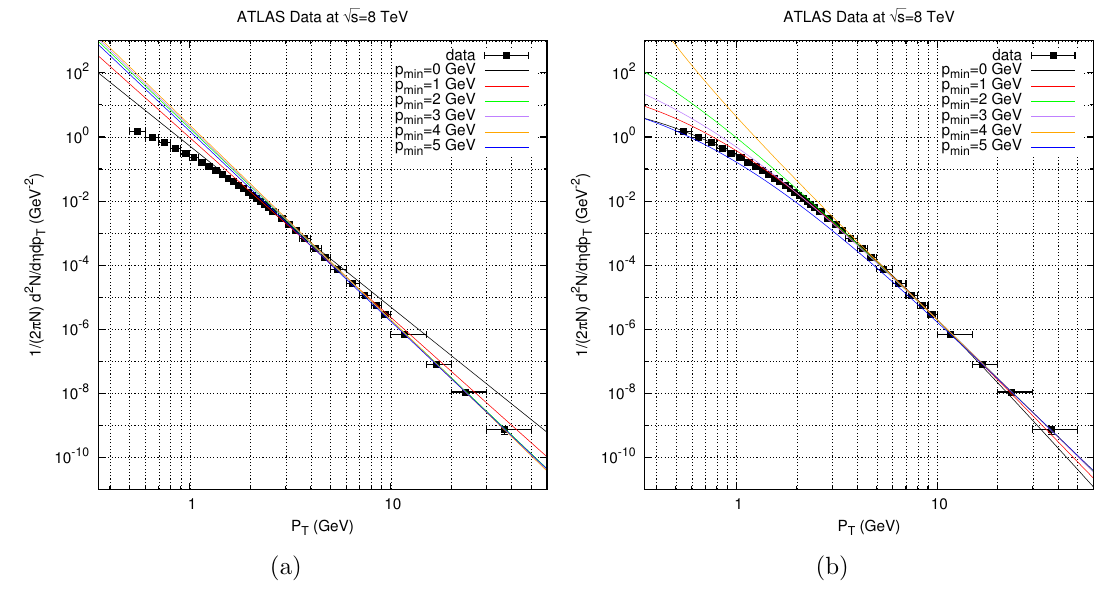
Figure 10. Fit of the two parameter ansatz in eq. (E.2) (left) and the three parameter ansatz in eq. (E.3) to the ATLAS dataset at p s = 8 TeV [94] with various data